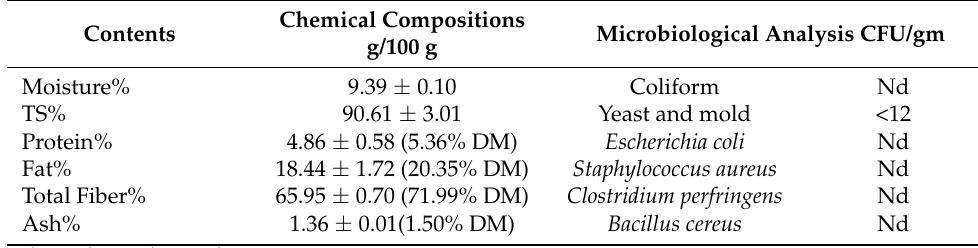
Table 2. Chemical and microbiological characterization of